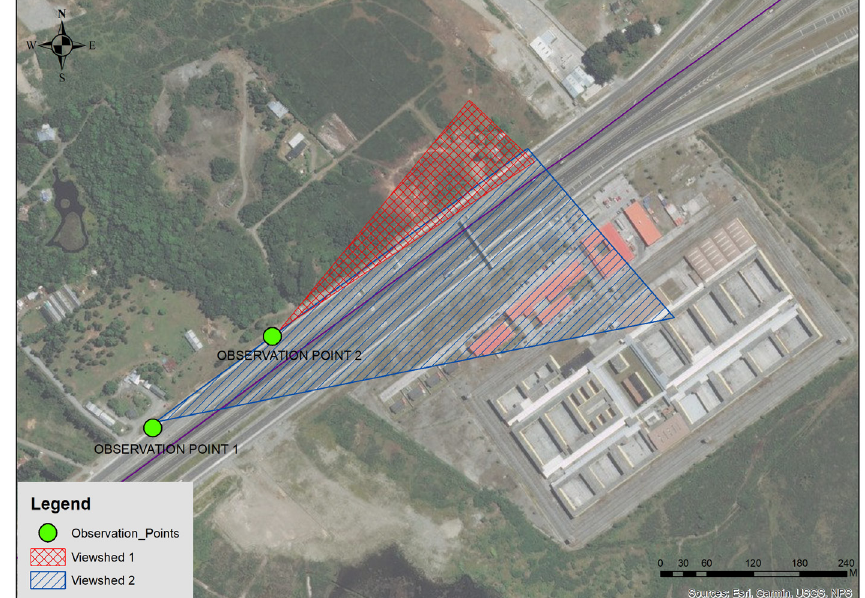
Figure 2: Map showing the place pictures were taken at Route 5 South Km 6. Illustrating trees and visual obstacles on the left side of the road and the man-made constructions. The triangles show the visual shed and openness degree. The area included in the visual basin is 0,3675km 2